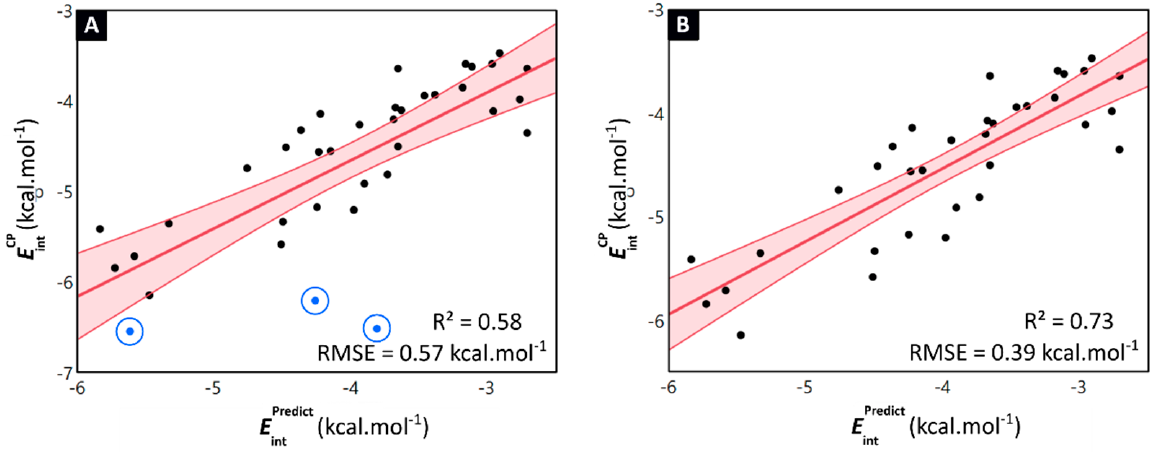
Figure 8. ( A ) Scatterplot of all Phe-dimer level counterpoise-corrected interaction energies E CP int and the predicted interaction energies E Predict int obtained through the monomer level model. Both values are expressed in kcal · mol − 1 . The linear fitting curve and associated confidence interval are shown in red and accompanied by the R 2 -value and RMSE. The m Cl- m Cl , m Br- m Br and m I- m I dimers have been highlighted by a blue circle. ( B ) A remarkable improvement of the fit is obtained when excluding the m Cl- m Cl , m Br- m Br and m I- m I dimers.